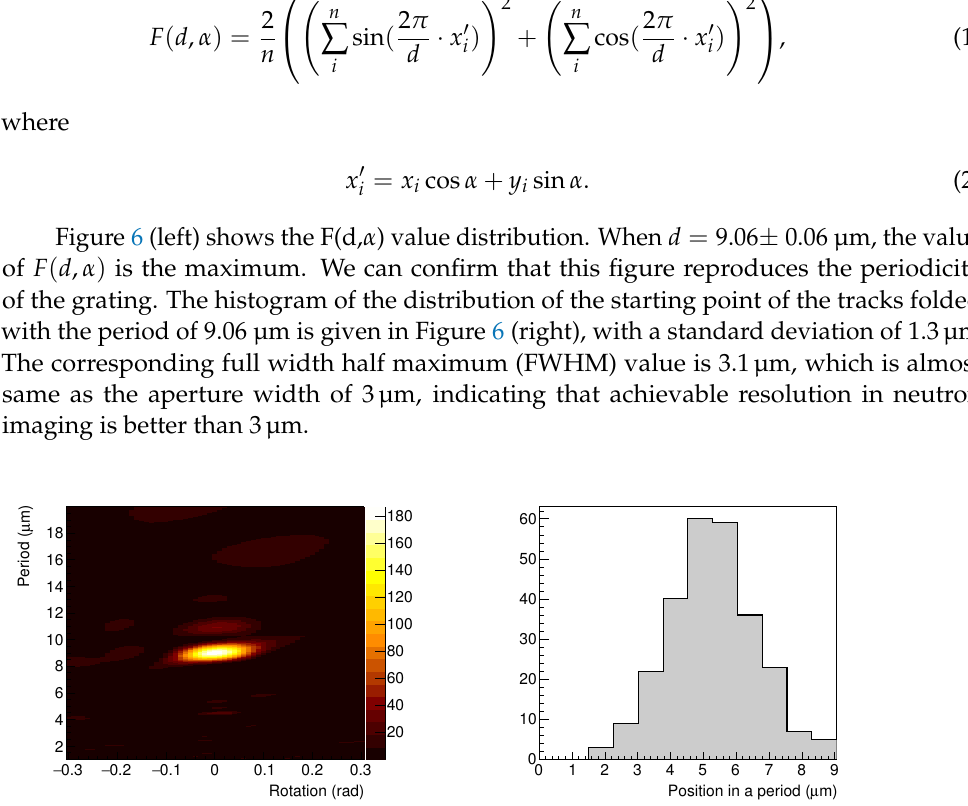
Figure 6. ( Left ) Results of the Rayleigh test. ( Right ) Distribution of the starting points of the tracks folded with the period of 9.06